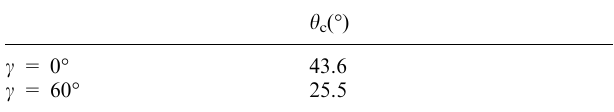
Table 8. Critical latitude values ( h c ) for the meridional ( c (cid:136) 0 (cid:14) ) and non meridional ( c (cid:136) 60 (cid:14) ) boundaries. T = 360 days